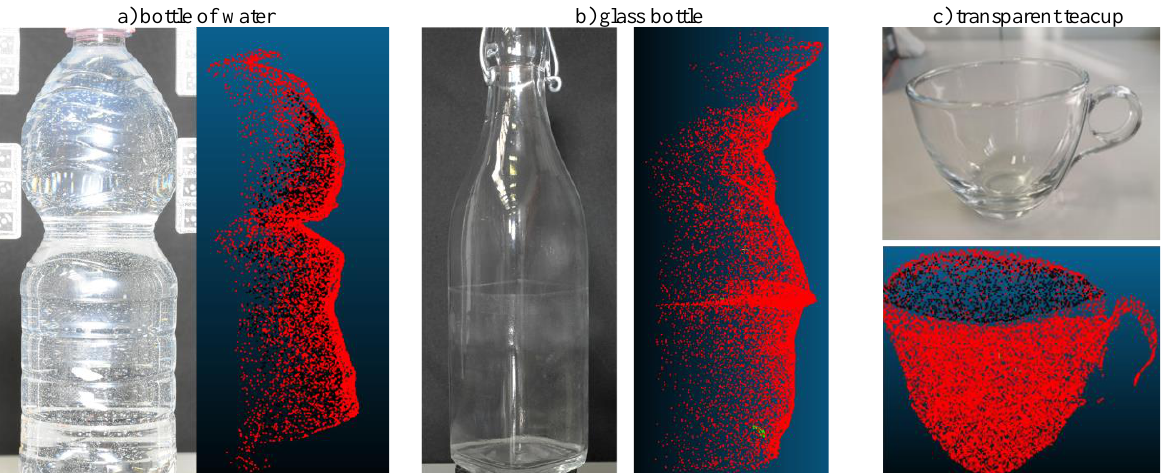
Figure 6. Learning-based 3D reconstruction of three transparent objects (bottle of water, glass bottle, and teacup) from a single image based on Eppel et al.